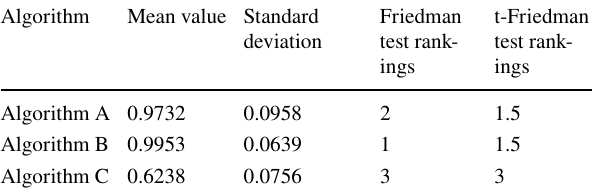
Table 2 Illustrative results with three algorithms Algorithm